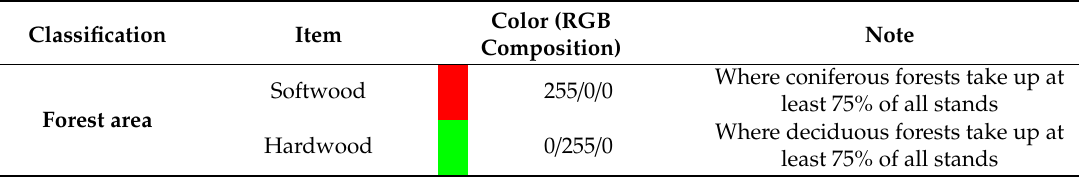
Figure 7. Example of constructed dataset. ( a ) is image data and ( b ) is grayscale ground truth data. Table 2. Label class in this Table 2. Label class in this study.